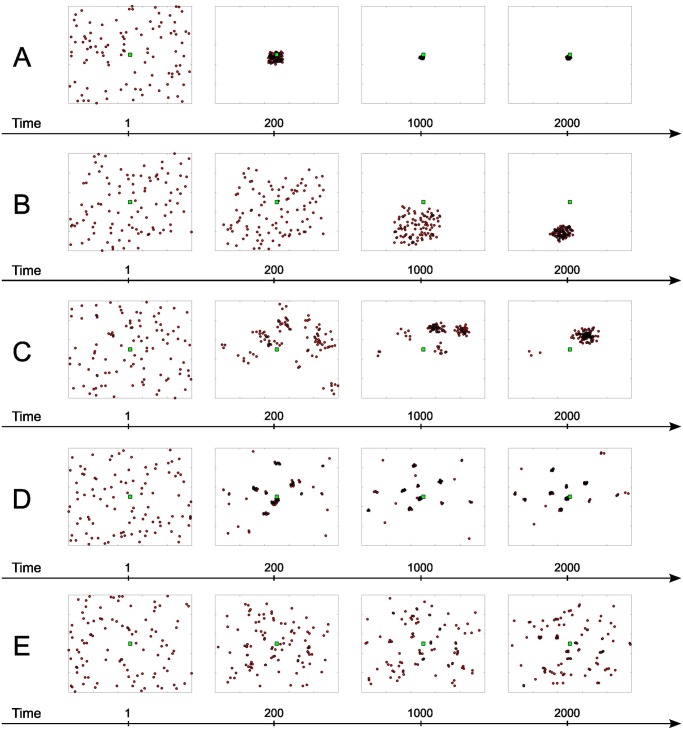
Ideal typical runs showing different patterns of consensus and level of scientific progress at four time steps: t = 1, 200, 1000, 2000.Panel A shows a steady trend towards consensus ending up almost perfectly on the ground truth [R = 0.3, α = 0.5, τ = 0.9, σ = 0.01, ε = 0.1]. In Panel B, the same process of convergence ends up far away from truth [R = 0.3, α = 0.5, τ = 10, σ = 0.01, ε = 0.1]. Panel C shows the emergence of different schools of thought, that gradually merge together in proximity of the truth [R = 0.06, α = 0.9, τ = 3, σ = 0.02, ε = 0.25]. Panel D shows the emergence of many small clusters that persist over time[R = 0.03, α = 0.9, τ = 1, σ = 0.01, ε = 0.1]. Finally, in Panel E the process of school formation is so slow that even at the end of the simulation a relevant share of agents is still isolated [R = 0.03, α = 0.01, τ = 1, σ = 0.01, ε = 0.1].